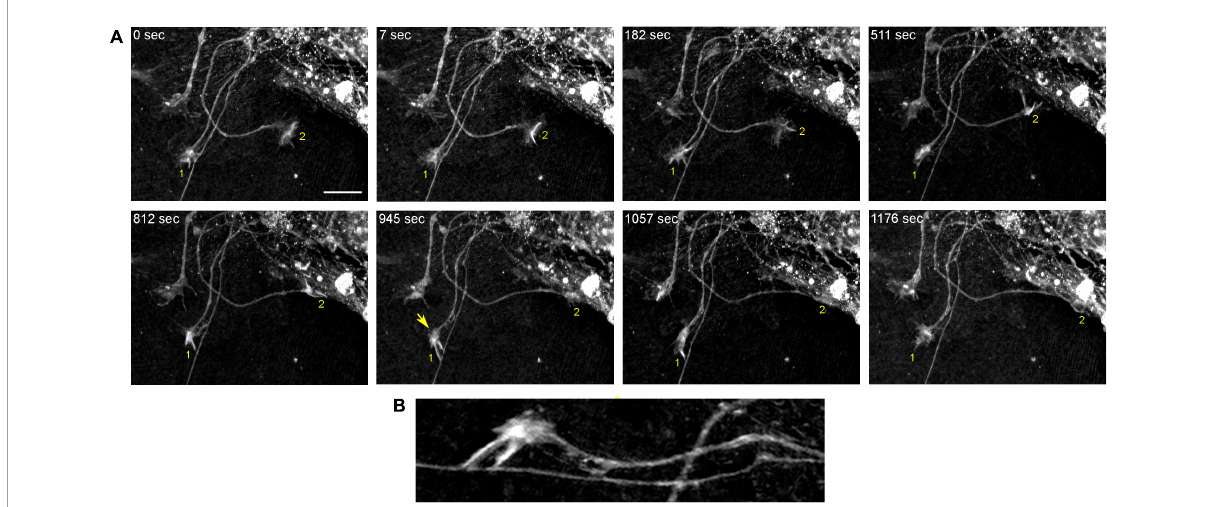
FIGURE6 The dynamics of two growth cones (GC; labeled 1 and 2) in a primary midbrain culture (monolayer at DIV 5), visualized with time-lapse holotomography ( Supplementary Video 1 ). (A) GC 1 attempts to move along a neurite by producing protrusions that come in contact with the neurite at well-defined points [arrow, enlarged in (B) ]. The distance between adjacent points is similar to that between the discrete 5-HT + regions in Figure 4 . GC 2 detects a substrate (around t = 511 s) and rapidly advances along its edge. To emphasize key transitions, time points are not evenly spaced. This imaging supports the interpretation of the dynamics that may underly the confocal microscopy data, but the recorded axons are not labeled and may not be serotonergic. Scale bar = 10 µ